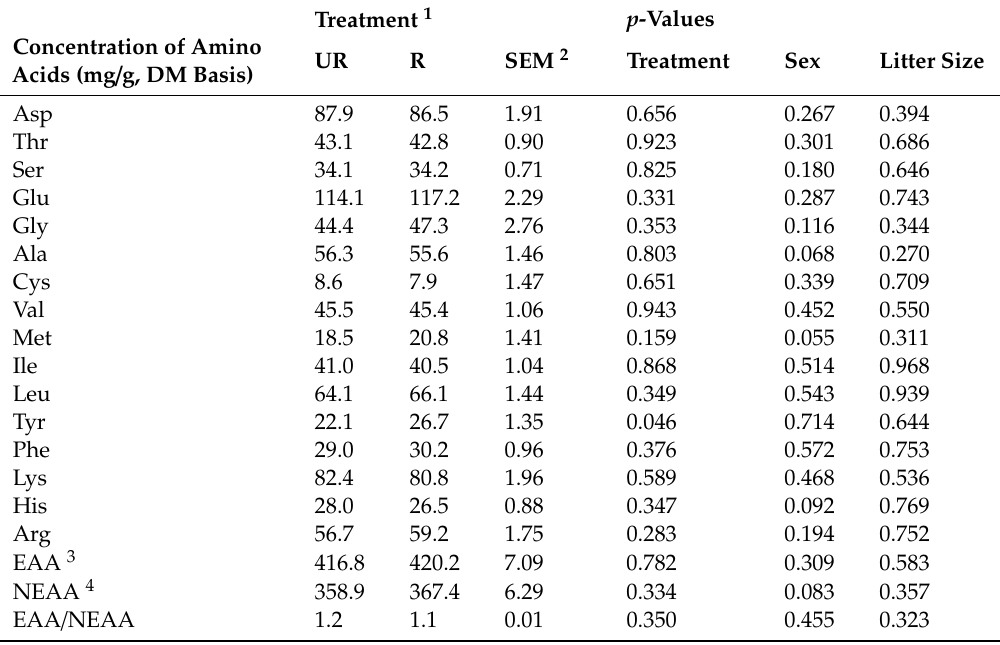
Table 7. E ff ect of maternal undernutrition during mid-gestation on the amino acid concentrations in the Longissimus thoracis of kids at 90 d of